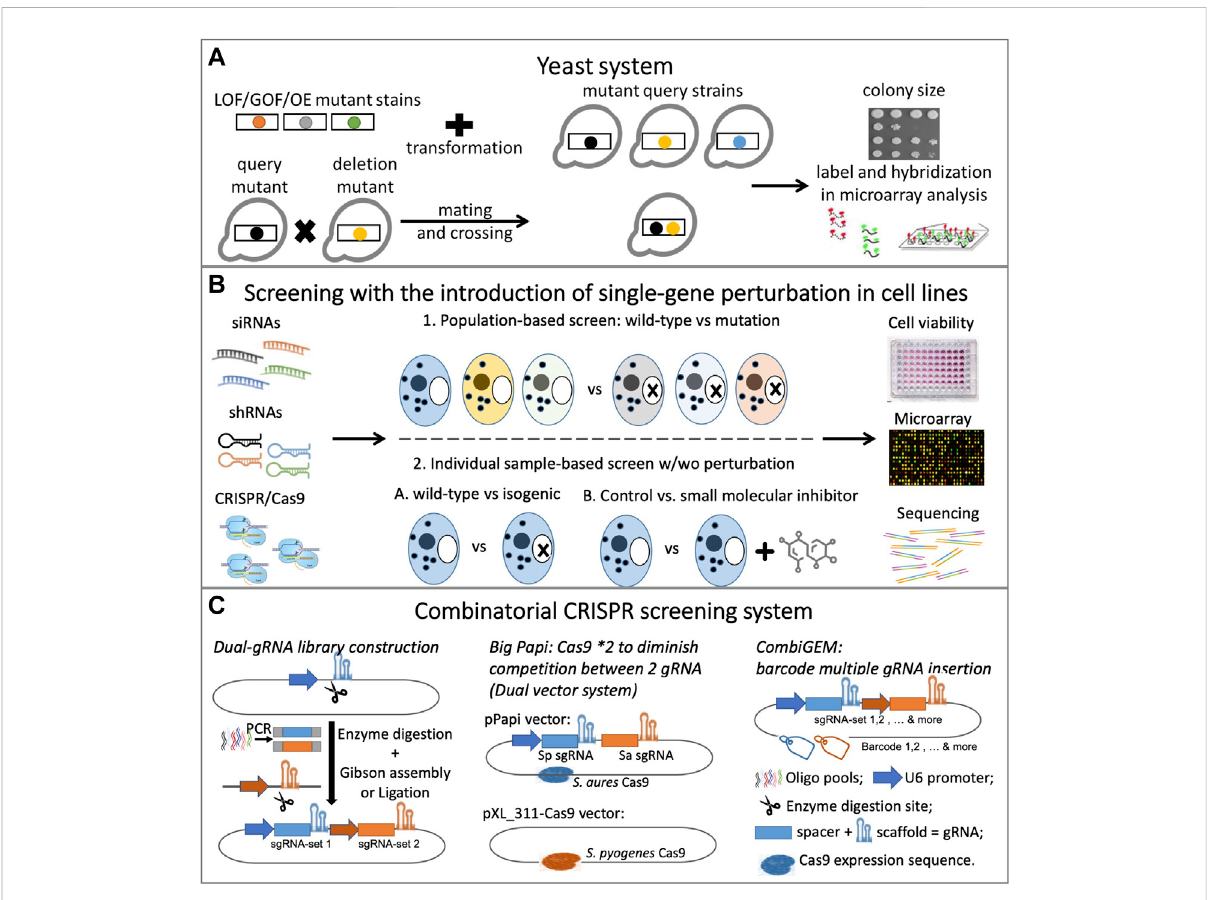
FIGURE 1 Overview of synthetic lethality experiments: (A) Yeast system with double mutant introduced by either transformation or mating; (B) Screening with single-geneperturbation introduced by mutation, chemical inhibitor, RNAior CRISPR; (C) Combinatorial CRISPR screening system: dual-gRNA library construction and